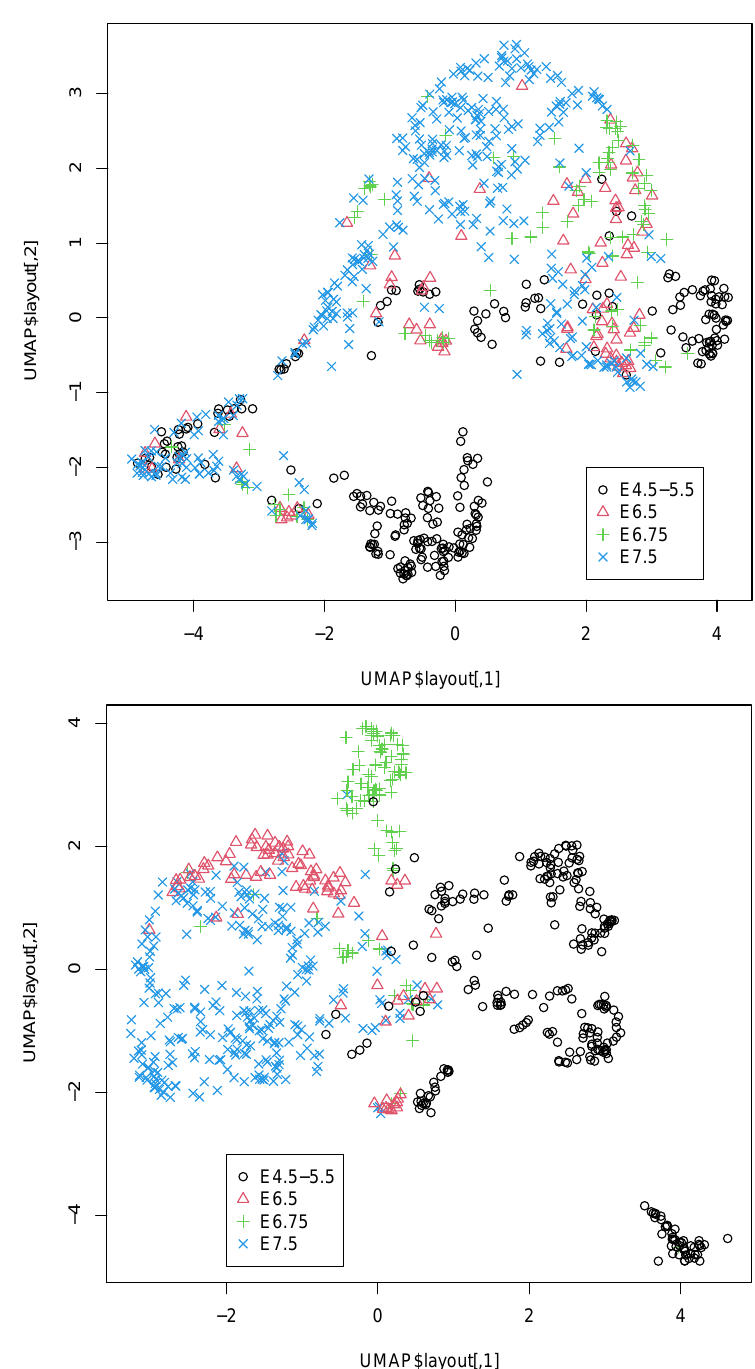
Figure 2. Two-dimensional embedding of singular-value vectors, u (cid:96) , computed by HOSVD applied 2 j to x (cid:96) jk in Dataset 2 (Table 4). Upper: u (cid:96) ,1 ≤ (cid:96) 2 ≤ 20 when only DNA methylation and accessibility 2 j ( k = 2,3 ) are integrated. Lower: u (cid:96) ,1 ≤ (cid:96) 2 ≤ 30 when all three omics data points (1 ≤ k ≤ 3) are 2 j integrated. Default settings other than custom.config$n_neighbors = 100 were